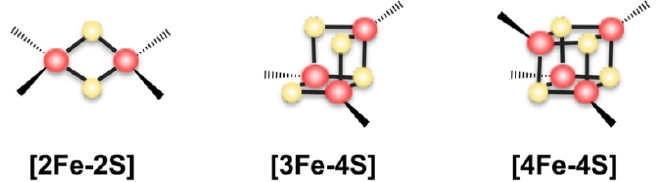
Figure 1. Three common types of Fe-S clusters. Shown are the structures of a rhombic [2Fe-2S] and a cubane [4Fe-4S] cluster. The [3Fe-4S] cluster can be generated by the loss of iron from a [4Fe-4S] cluster. Sulfur is symbolized in yellow and iron is represented in red.